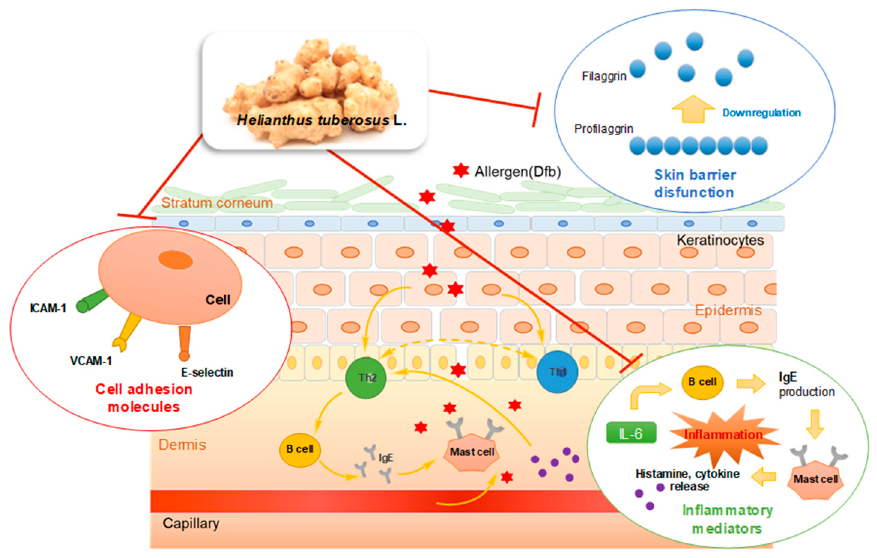
Figure 7. Graphical Abstract: Underlying molecular mechanisms in the anti-AD effect of HT.